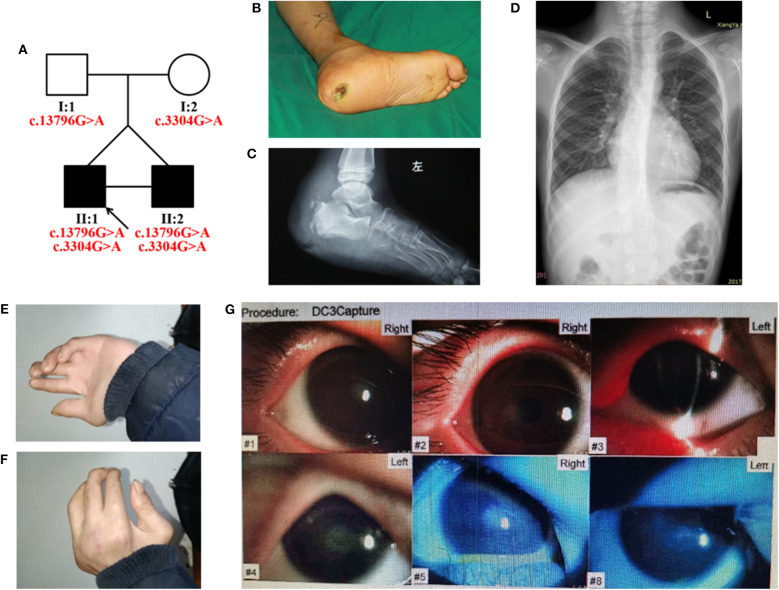
(A) Pedigree of the HSAN-VI family with segregation analysis. The black symbols represent the affected members, and the arrow indicates the proband. Red text represents the variants. (B–G) Aspects of the phenotype of the proband. The proband has an ankle ulcer (B), necrosis of the astragalus (C), moderate scoliosis (D), phalangeal joint contracture (E,F), and cataract (G).